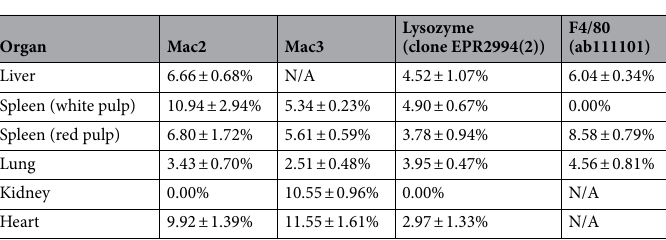
Table 1. Percentage of PDGFR α + fibroblasts labeled by macrophage-specific